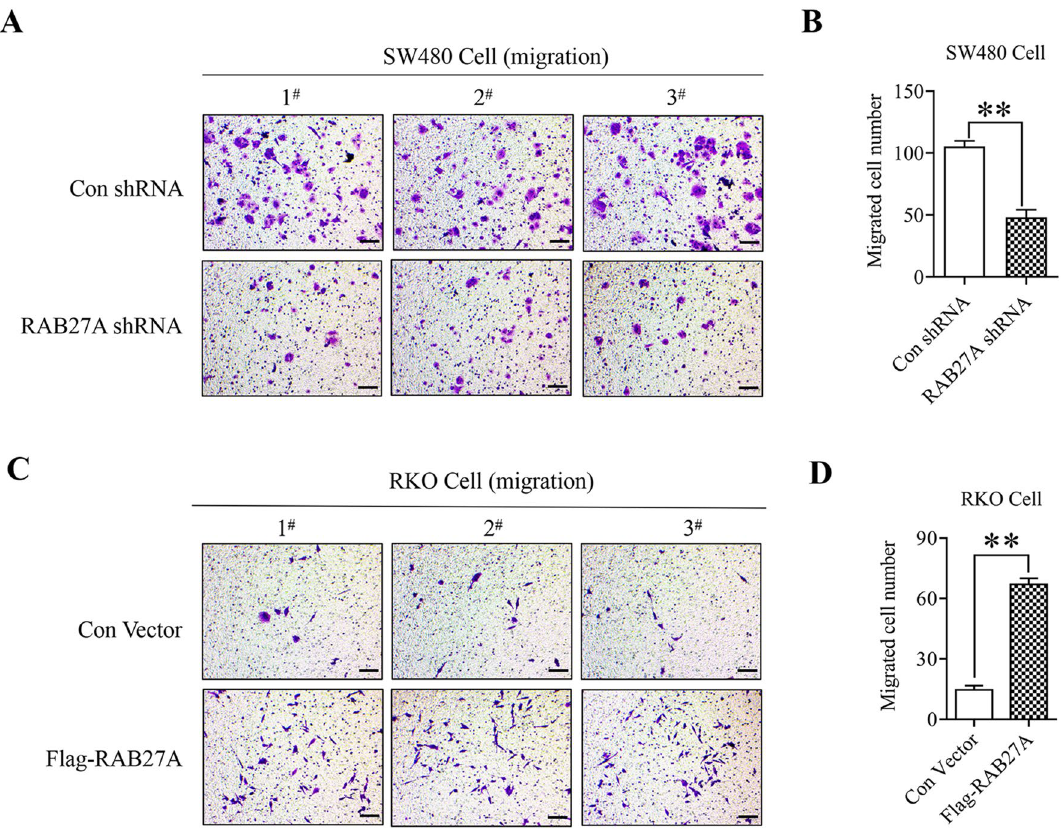
Figure 4. The effect of RAB27A on colon cancer cell migration. ( A,B ) RAB27A knockdown suppresses the migration of SW480 cells. RAB27A knockdown and the negative control SW480 cells were seeded in the upper well of the Transwell chamber for 48 h, and the migrated cells were stained with the crystal violet. ( C,D ) RAB27A overexpression facilitates RKO cell migration. RAB27A overexpression cells and the negative control cells were seeded in the upper well of the Transwell chamber for 48 h, and the migrated cells were stained with the crystal violet. Cell migration was determined by microscopy (200×). At least three fields in each group were observed, and the representative images were shown (scale bar = 100 µm). Migrated cell number in each field was shown as mean ± S.D. and was analyzed by two-tailed t-test. And the value of the vertical axes in this figure is migrated cell number per field of view. ** P < 0.01. All the experiments were repeated three times independently and the representative results were